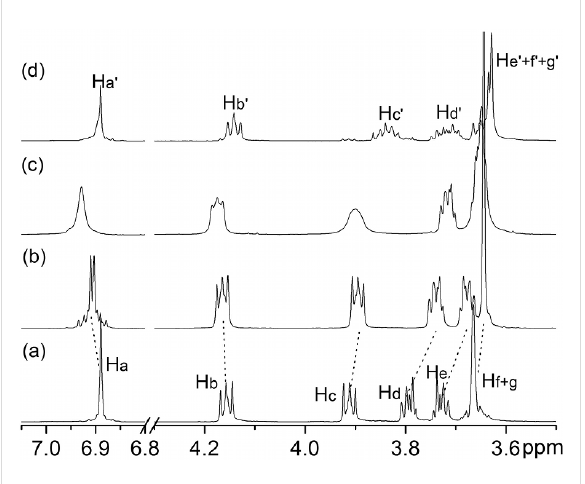
Figure 3: 1 H NMR spectra (500 MHz, 298 K, CDCl 3 , 10.0 mM) of ( a ) C7 , ( b ) C7 in the presence of 1 eq. KPF 6 , ( c ) the compound obtained after column chromatography from the KPF 6 -templated reaction, and ( d ) 2 -( n ).